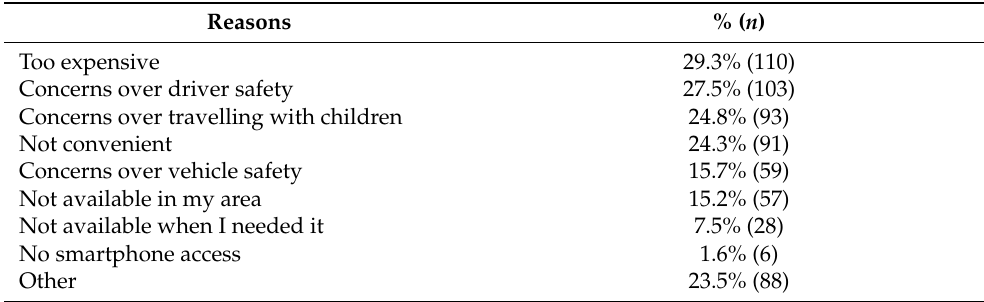
Table 4. Participants’ reasons for not travelling in a rideshare vehicle with their youngest child ( n = 375).